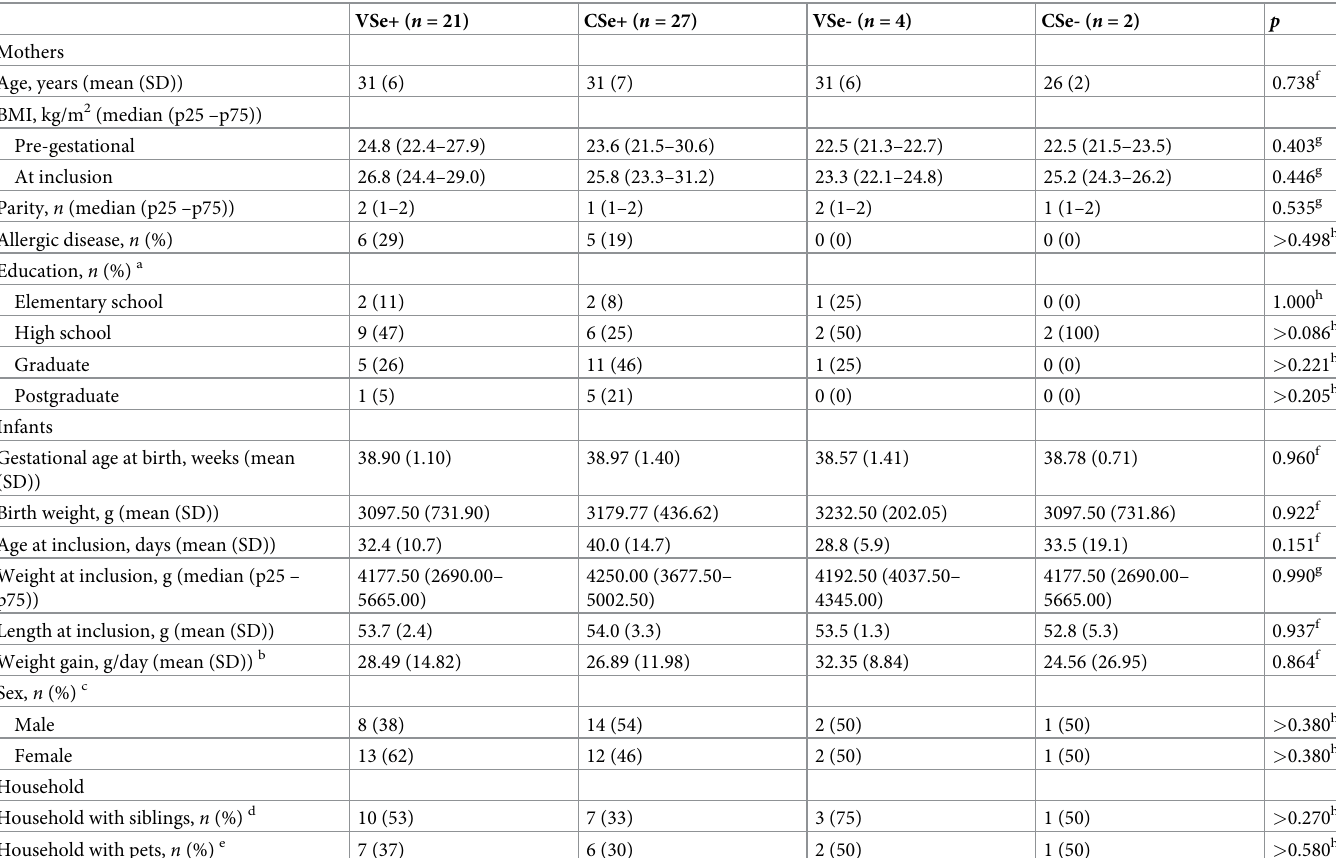
Table 1. Characteristics of the mothers and their exclusively breastfed infants according to the mode of birth and maternal secretor status. VSe+ ( n = 21)